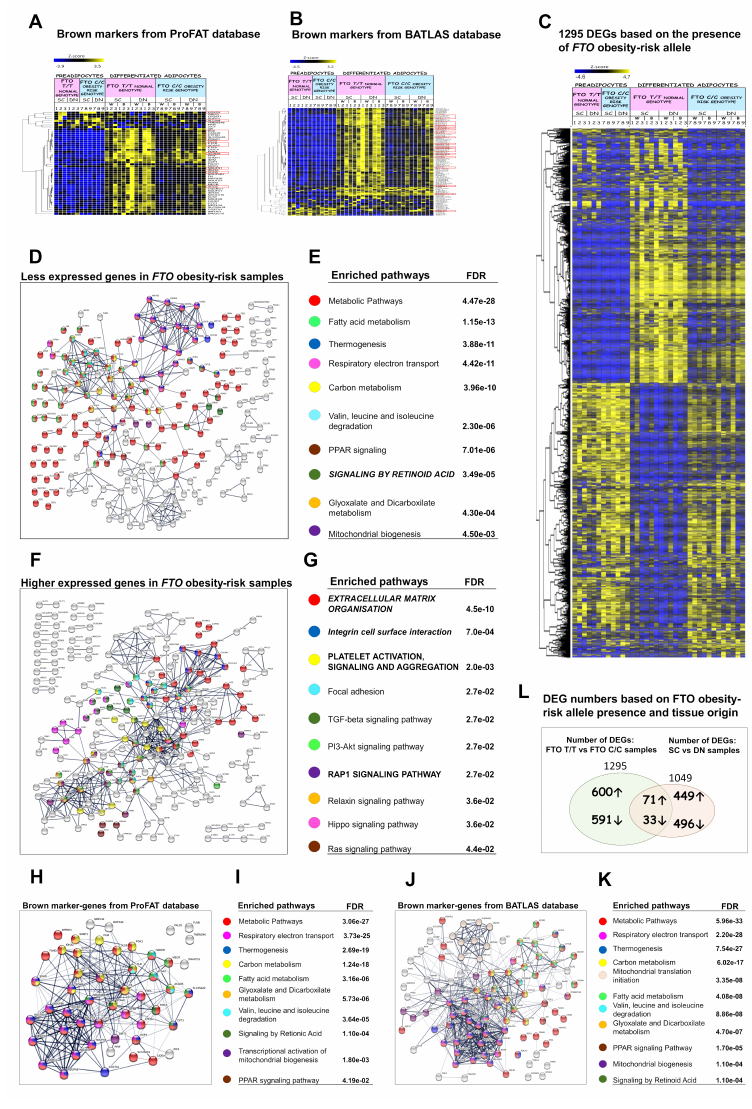
Figure 6. Gene expression analyses based on the presence of FTO obesity-risk allele. ( A ) Heat map shows the expression profile of marker genes from ProFAT database. ( B ) Heat map visualization shows di ff erences of brown marker genes based on BATLAS database; samples ordered; n = 6. ( C ) Heat map shows the expression profile of di ff erentially expressed genes (DEGs) based on the presence of FTO obesity-risk alleles in SC and DN adipose progenitors and di ff erentiated samples. ( D , E ) Interactome map and selected significantly enriched pathways, biological processes or cell components and their false discovery rate (FDR) values of lower expressed genes in FTO obesity-risk allele carrier samples, interaction score confidence value: 0.7. ( F , G ). Interactome map and selected significantly enriched pathways, biological processes or cell components and their FDR values of higher expressed genes in FTO obesity-risk allele carrier samples. Edges represent protein-protein based interactions. SC: subcutaneous DN: deep-neck, W: white di ff erentiation protocol; B: brown di ff erentiation protocol. ( H , I ) Interactome map and Significantly enriched pathways with their FDR values of ProFAT browning marker genes; interaction score confidence value: 0.4. ( J , K ) Interactome map and Significantly enriched pathways with their FDR values of BATLAS browning marker genes; interaction score confidence value: 0.4. Italic font: pathway also appears in preadipocyte state; Capital letters: Pathway also appears in FTO obesity-risk allele based comparison. ( L ) FTO genotype a ff ected genes among the DEGs in DN and SC samples. 1 to 9 labels the individual from which the sample was